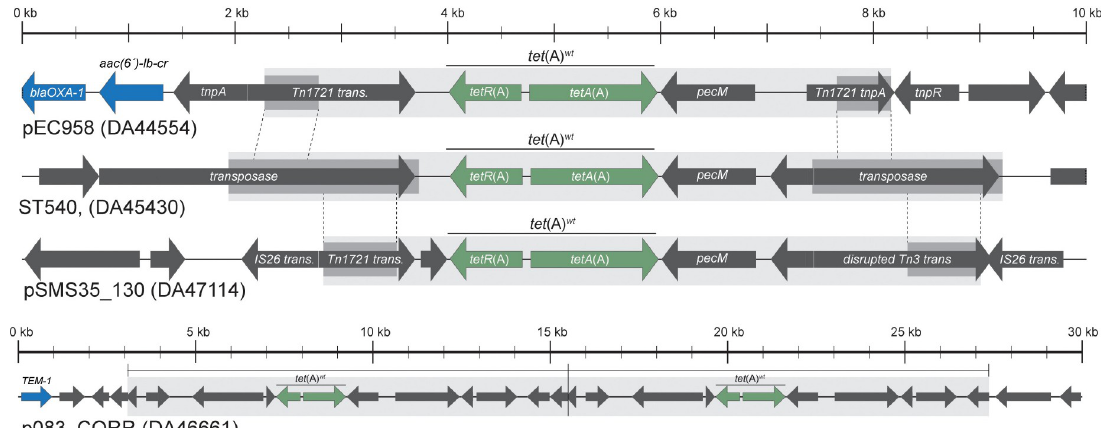
Fig 2. Genetic context of tet (A) wt and amplified units. Depicted are the amplified regions carrying tet (A) wt in mutants of DA44554, DA45430, DA47114, and DA46661, selected on 1 mg/L TGC. Genes shown in green are the primary genes of interest ( tetA (A) and tetR (A)). Dark grey boxes show the regions of direct repeat, while the light grey boxes show the amplified regions. Dashed lines indicate where regions of direct repeat are identical to those found in the other isolates. Genes shown in blue are other resistance genes. For DA46661, an initial duplication was observed in the parental isolate. TGC, tigecycline.